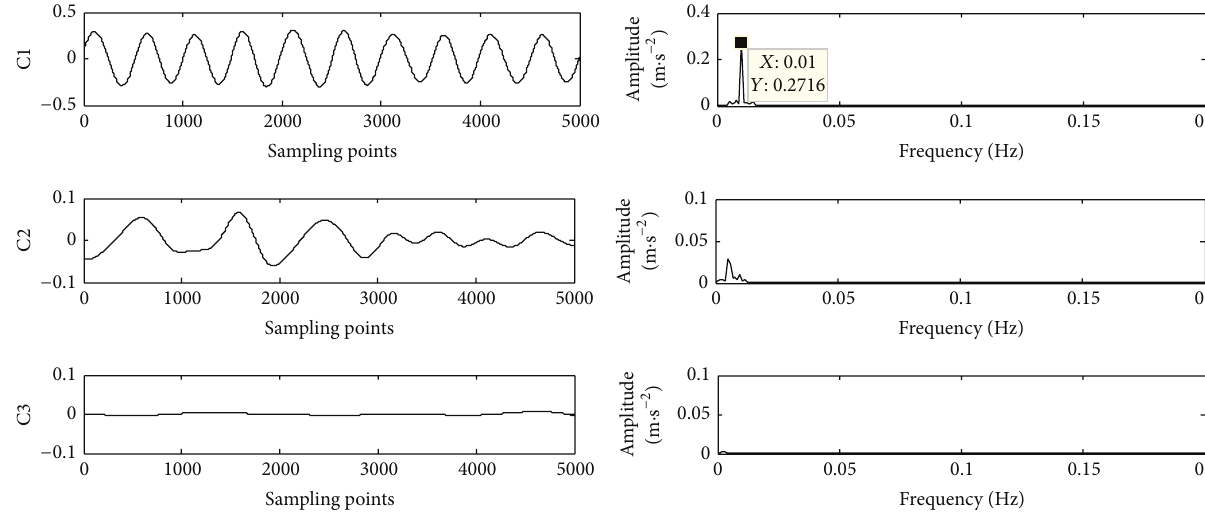
Figure 5: The AMD-EEMD components of original signal and its